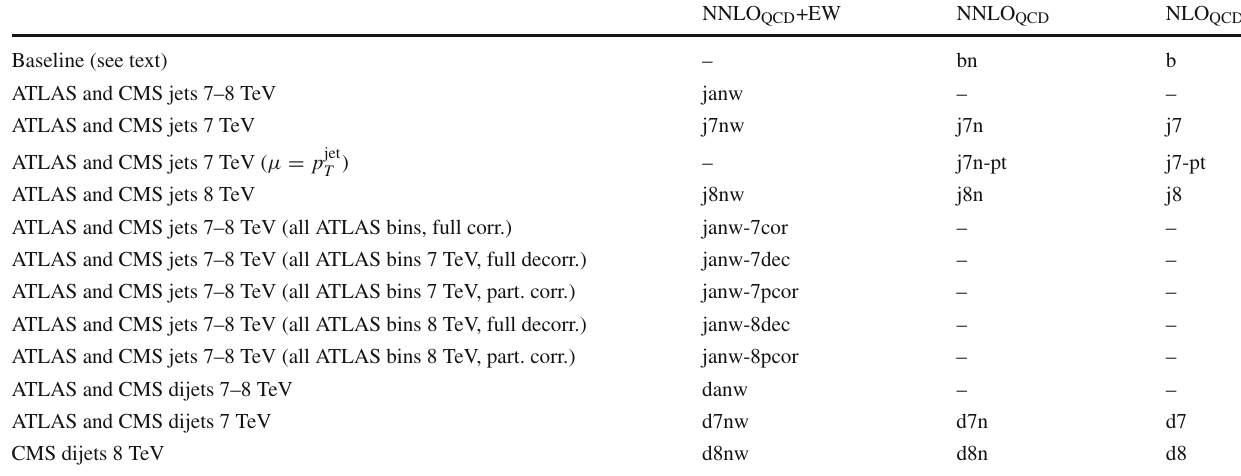
Table 2 The PDF determinations discussed in this study and their IDs. Each row corresponds to a different choice of input jet dataset or fit settings (listed in the first column), and each column corresponds to a different theory accuracy (listed in the first row). The ID encodes the process used (j for single-inclusive jets and d for dijets); the data used (a for all, 7 or 8 for the 7 TeV or 8 TeV datasets); the perturbative accuracy